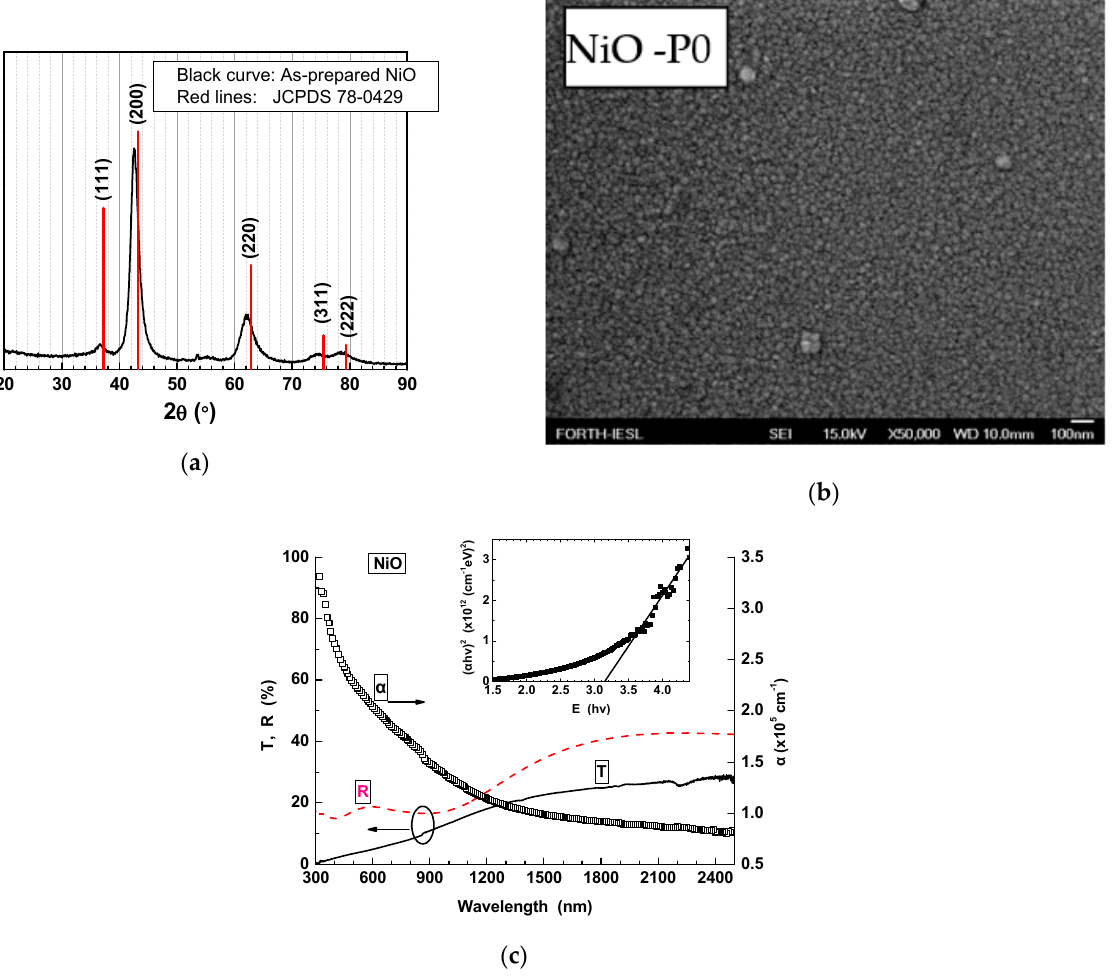
Figure 2. ( a ) XRD pattern, ( b ) SEM image and ( c ) UV-Vis-NIR transmittance, reflectance and absorption coefficient curves of NiO film (P0). The inset in ( c ) shows the ( α hv) 2 -vs-E plot for deducing direct Egap.